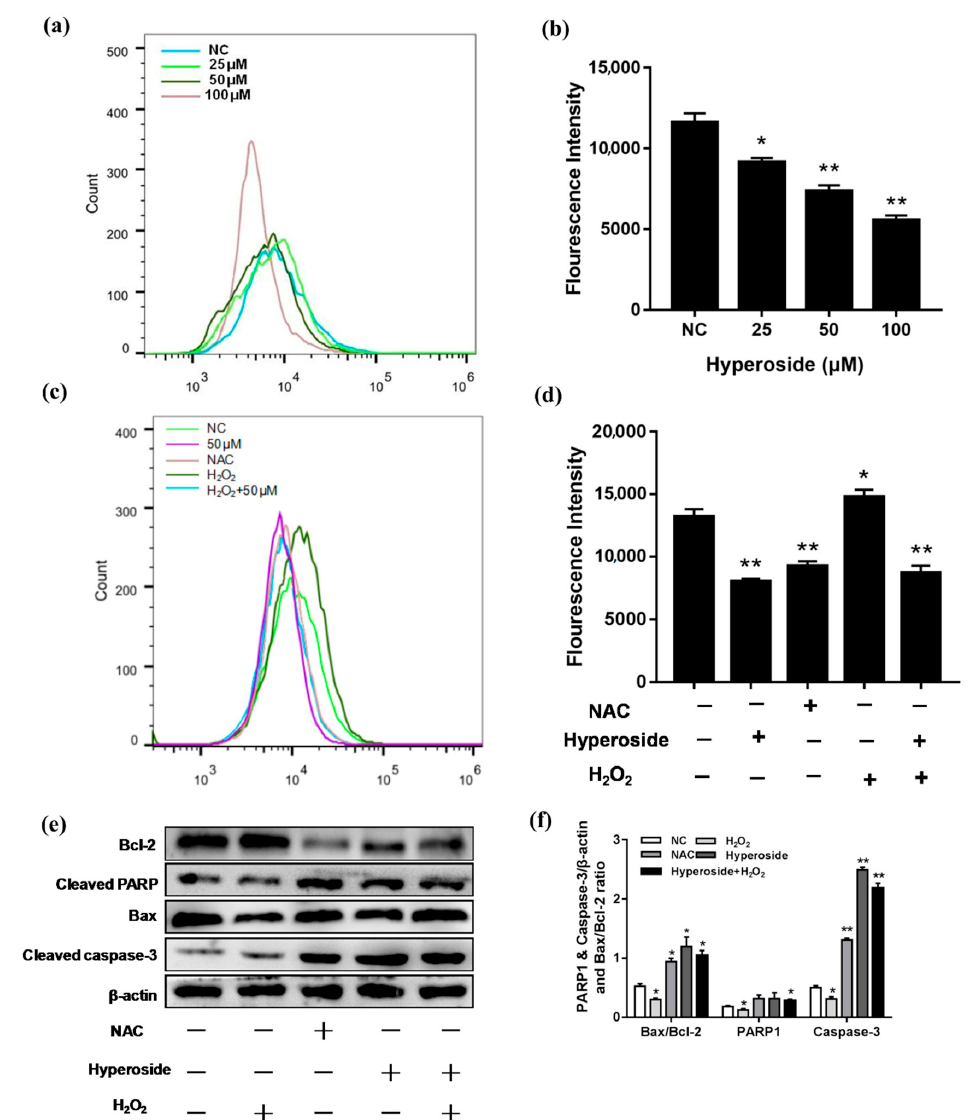
Figure 3. Hyperoside induces apoptosis by reducing intracellular ROS levels. ( a – d ) 4T1 cells were stimulated with di ff erent concentrations (25, 50 and 100 µ M). NAC: Cells were stimulated with 10 mM NAC; H 2 O 2 : Cells were stimulated with 25 µ M H 2 O 2 ; hyperoside + H 2 O 2 : Cells were co-stimulated with 25 µ M H 2 O 2 and 50 µ M hyperoside. All these groups were performed for 24 h. The intracellular ROS levels were measured by staining with DCFH-DA (10 mM) for 30 min and then determined by flow cytometry. ( e , f ) 4T1 cells were stimulated with hyperoside (50 µ M), NAC (10 mM), H 2 O 2 (25 µ M), and hyperoside (50 µ M) + H 2 O 2 (25 µ M) for 24 h, respectively. The proteins levels of cleaved caspase-3, Bax, cleaved PARP, and Bcl-2. β -actin were used for normalization. Data are expressed as mean ± SD of three independent experiments. * p < 0.05, ** p < 0.01 (Student’s t